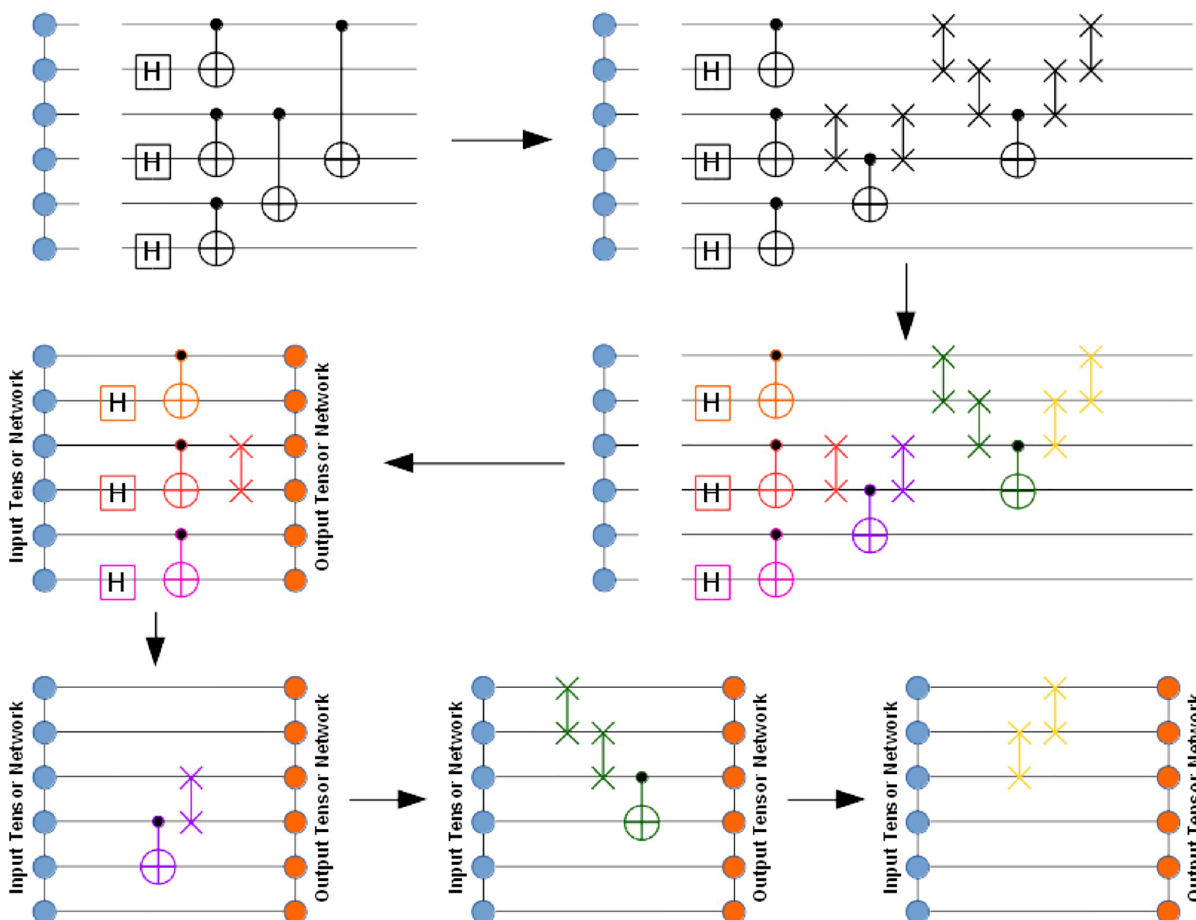
Fig 2. Graphical illustration of the general quantum circuit simulation algorithm with the multi-qubit wave-function factorized as the MPS tensor network. Gate coloring represents aggregation of individual gates into super-gates, which act as a whole. The figure shows progression of super- gate actions on the MPS tensor network. Multiple super-gates may be involved in a single action. Each action results in an updated MPS tensor network (output tensor network). Note that the application of a super-gate does not necessarily affect all output MPS tensors, only requiring an update of a subset of them that is actually affected by the super-gate. In general, the affected tensors are determined by the qubits involved in the super-gate as well as the specific tensor network architecture.